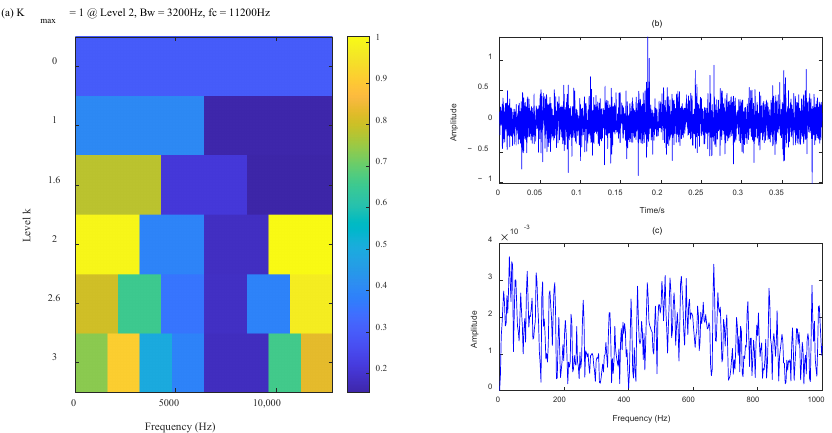
Figure 26. Processing 2400 r/min compound fault signal with Fast Kurtogram: ( a ) Kurtogram diagram, ( b ) Filtered signal, and ( c ) its square envelope spectrum.